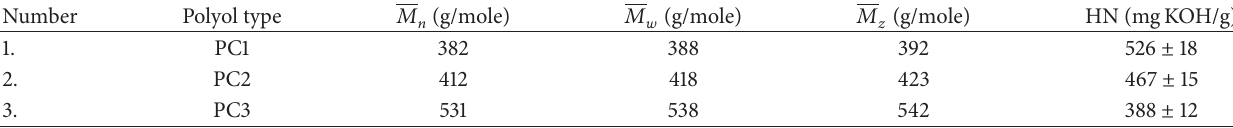
Table 3: Molar masses of some obtained polyols determined by means of GPC method.